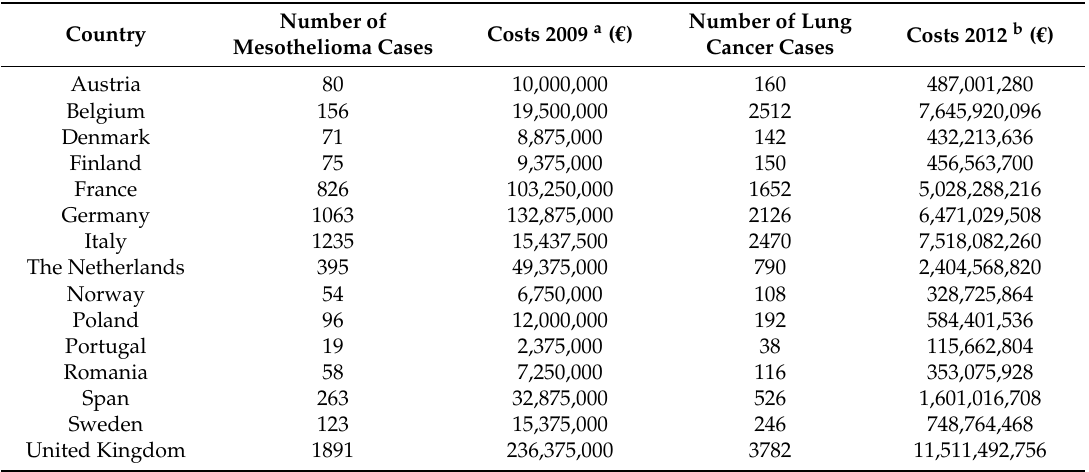
Table 5. Estimates of mesothelioma costs of 15 European countries